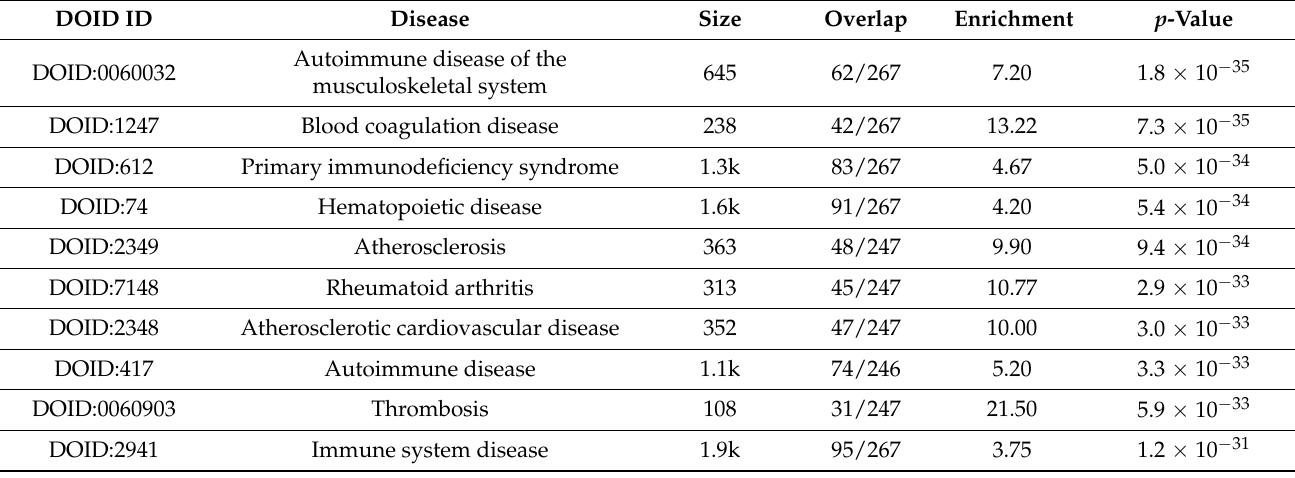
Table 5. Results of inBio Discover annotation analysis with the DOID disease annotations classification in ischemic death due to stroke proteins and genes.